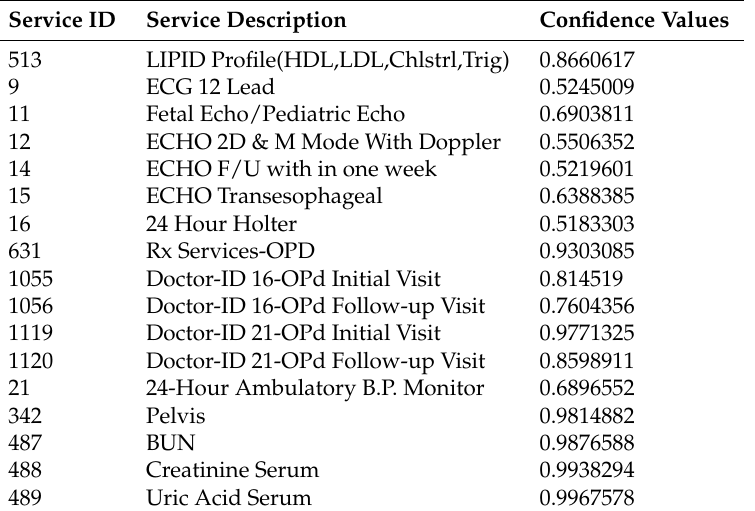
Table 6. Services and their confidence values for Pediatric Cardiology.